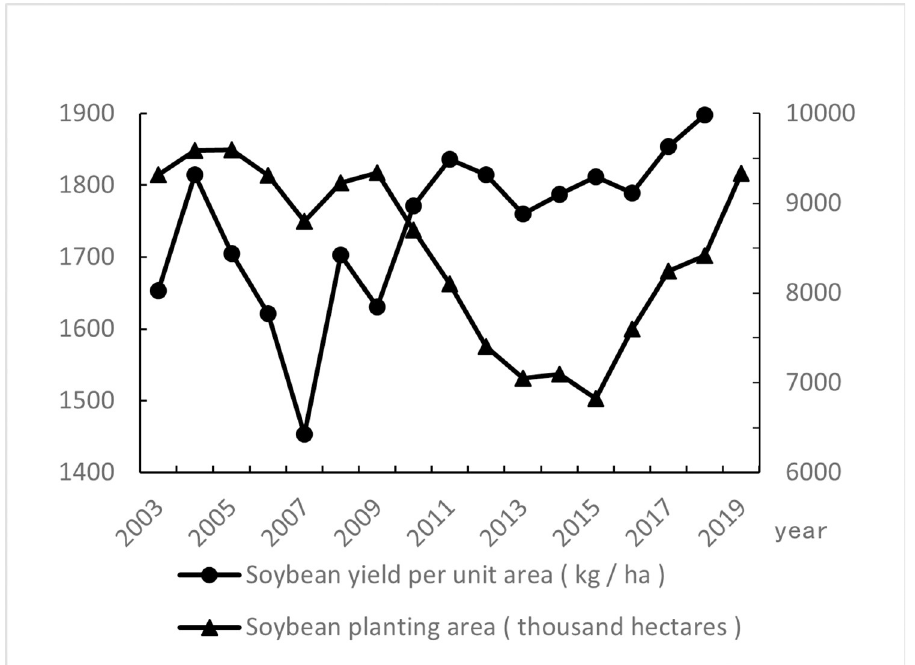
Fig 1. Trend chart of soybean planting area and yield per unit in China from 2003 to 2019.